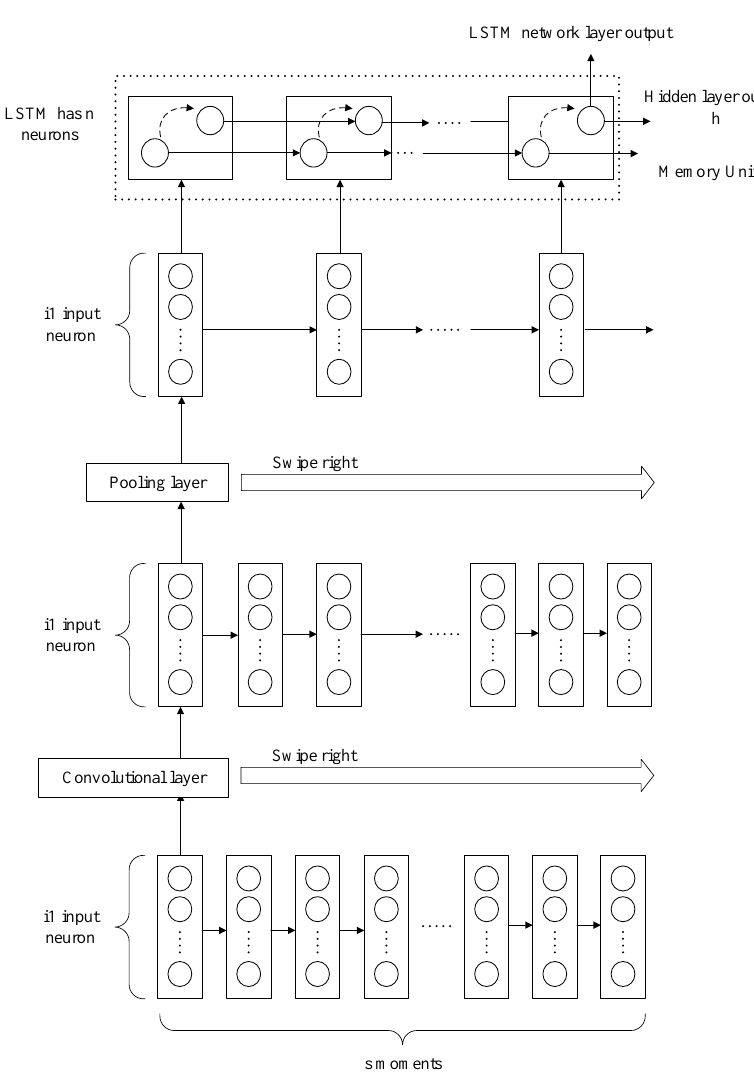
Figure 3. CNN-LSTM network architecture.